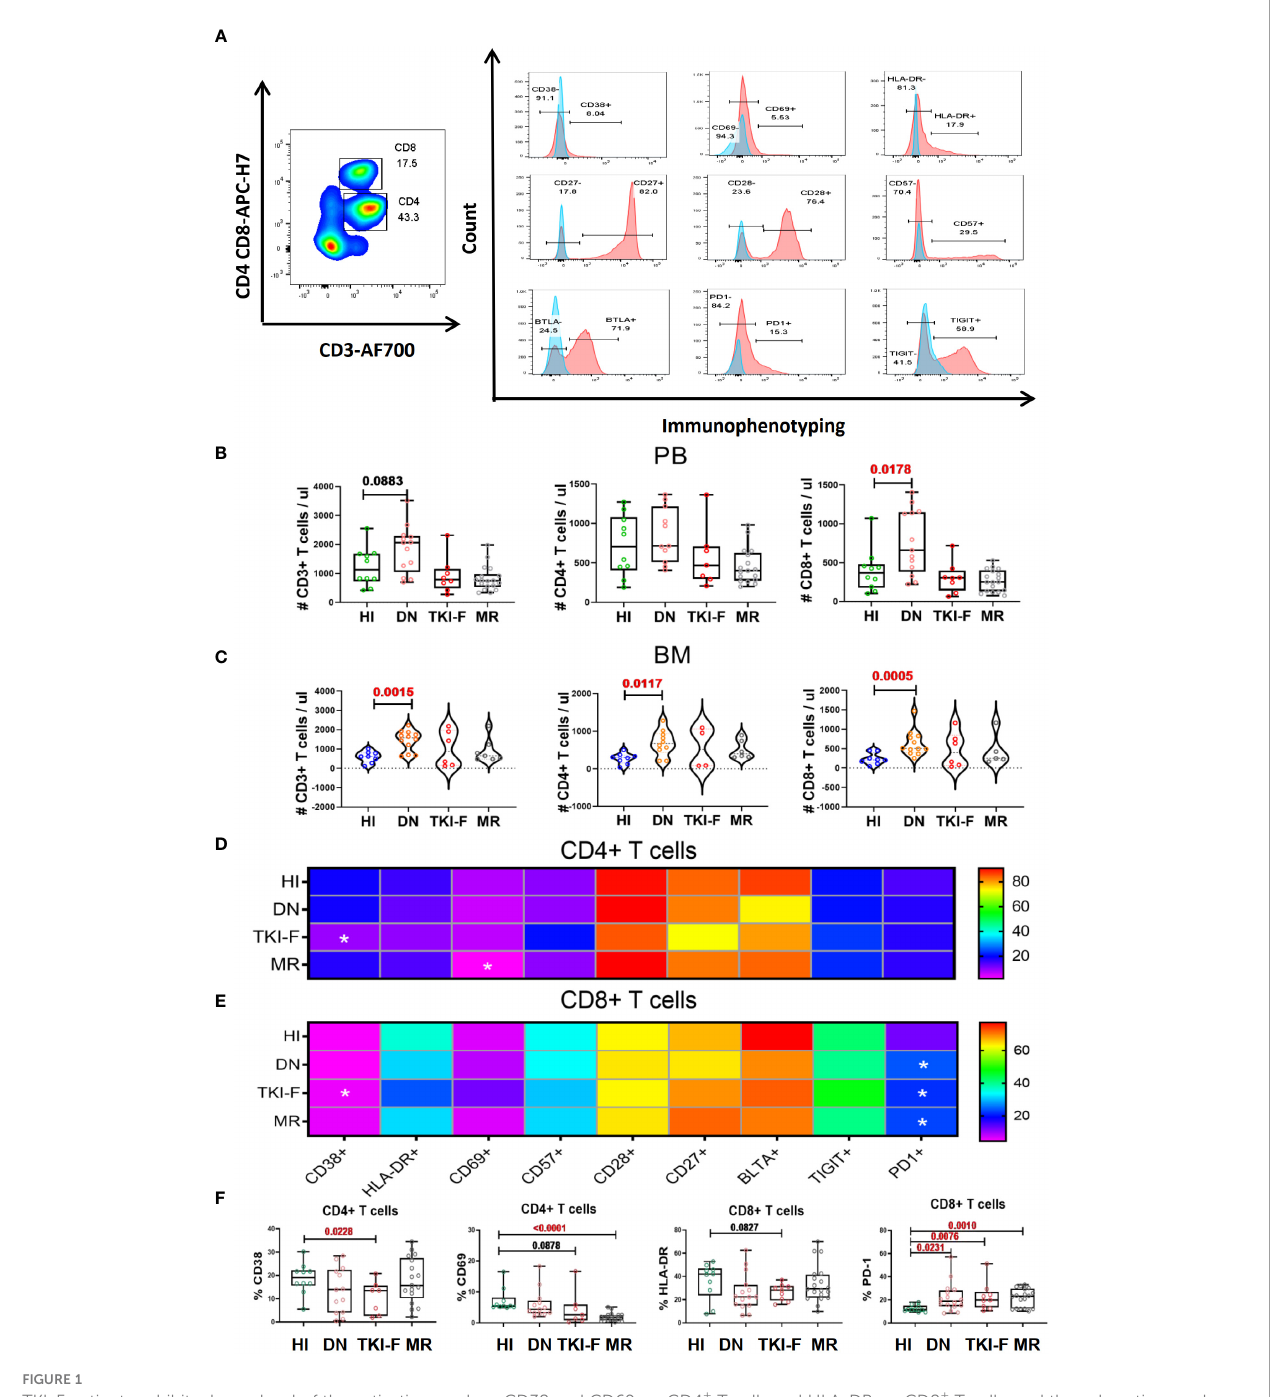
FIGURE 1 TKI-F patients exhibit a lower level of the activation markers CD38 and CD69 on CD4 + T cells and HLA-DR on CD8 + T cells, and the exhaustion marker PD-1 increased on PB-CD8 + T cells in all CML groups. (A) The top fi gure shows the gating strategy for CD38, CD69, HLA-DR, CD28, CD57 BTLA, TIGIT, and PD-1 in the CD4 + and CD8 + populations by fl ow cytometry. The absolute number of CD3 + , CD4 + , and CD8 + T cells in the PB and BM (B, C) The darkness of the color represents the mean frequency of a single immune marker on CD4 + (D) and CD8 + (E) T cells in PB from HIs and DN-CML, TKI-F, and MR patients. The asterisk (*) represents a signi fi cant alteration in CML patients compared with HIs. (F) The proportion of CD38 + CD4 + , CD69 + CD4 + , HLA-DR + CD8 + , and PD-1 + CD8 + in PB from HIs and DN-CML, TKI-F, and MR patients. HIs-PB (CD4, n = 12, CD8, n = 12), DN-CML-PB (CD4, n = 12, CD8, n = 16), TKI-F-PB (CD4, n = 7, CD8, n = 9), and MR-PB (CD4, n = 17, CD8, n = 20). The P values shown are from the Mann-Whitney U test between